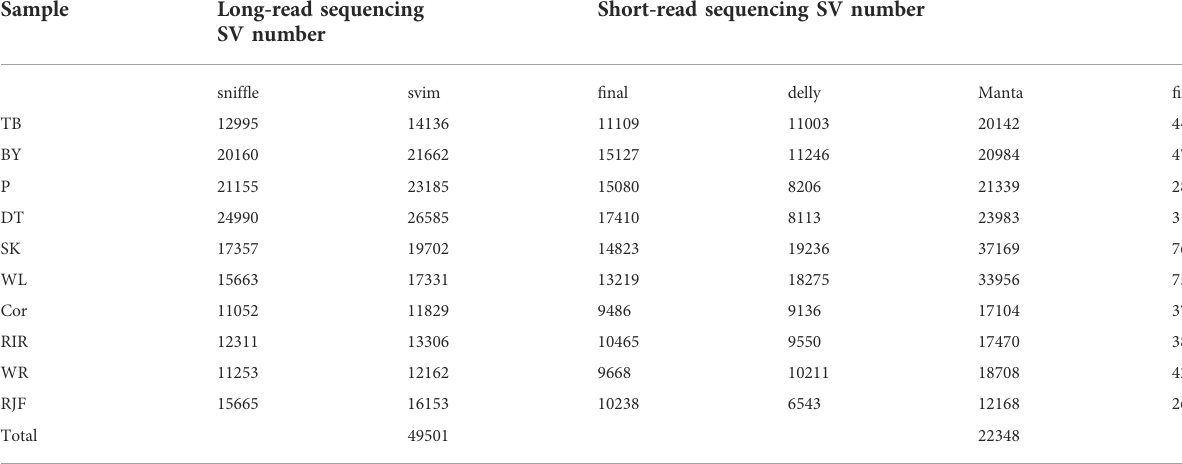
TABLE 2 Number of SVs detected by Illumina short reads and PacBio long reads in 10 chicken samples.